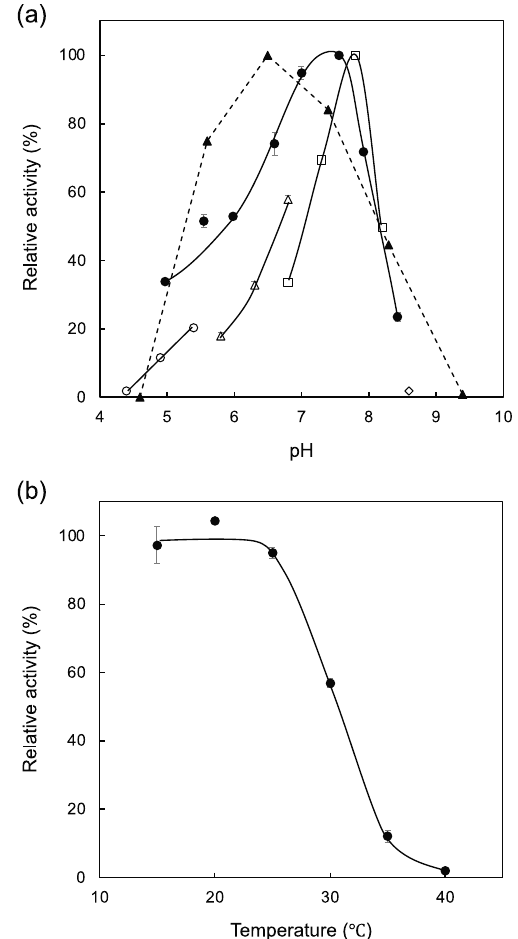
Figure 4. Effects of pH and temperature. (a) Effect of pH. Closed circles show activity of the phosphorolysis. Open symbols indicate activity of reverse phosphorolysis. Circles, triangles, squares, and diamond show the reaction in sodium acetate buffer, MES-NaOH buffer, HEPES–NaOH buffer, and glycine–NaOH buffer, respectively. Closed triangles show residual activity after the pH treatment at pH 4.6–9.4 at 4 °C for 24 h. (b) Temperature stability. Residual activity after the heat treatment at 15–40 °C for 15 min is shown. Values and error bars indicate average and standard deviation for three independent experiments,